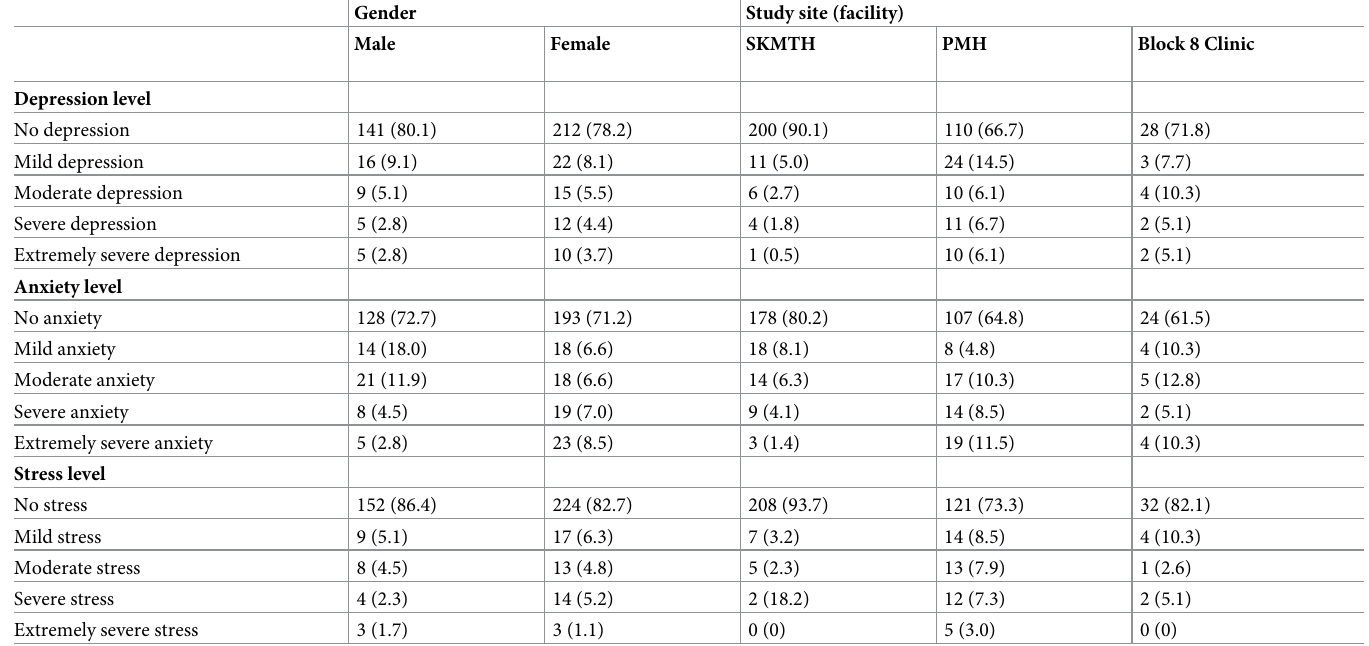
Table 4. Depression, anxiety and stress levels according to gender and study site.